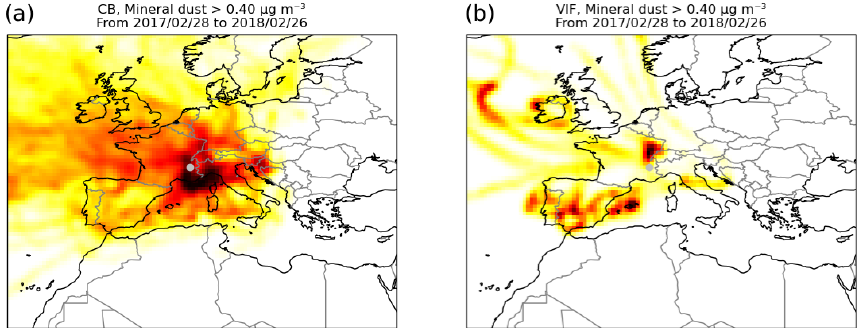
Figure 10. The PSCF analysis of the days with a mineral dust loading higher than 0.4µgm − 3 for the CB site (a) and Vif (b) . Darker shades indicate higher probability density of source origin.